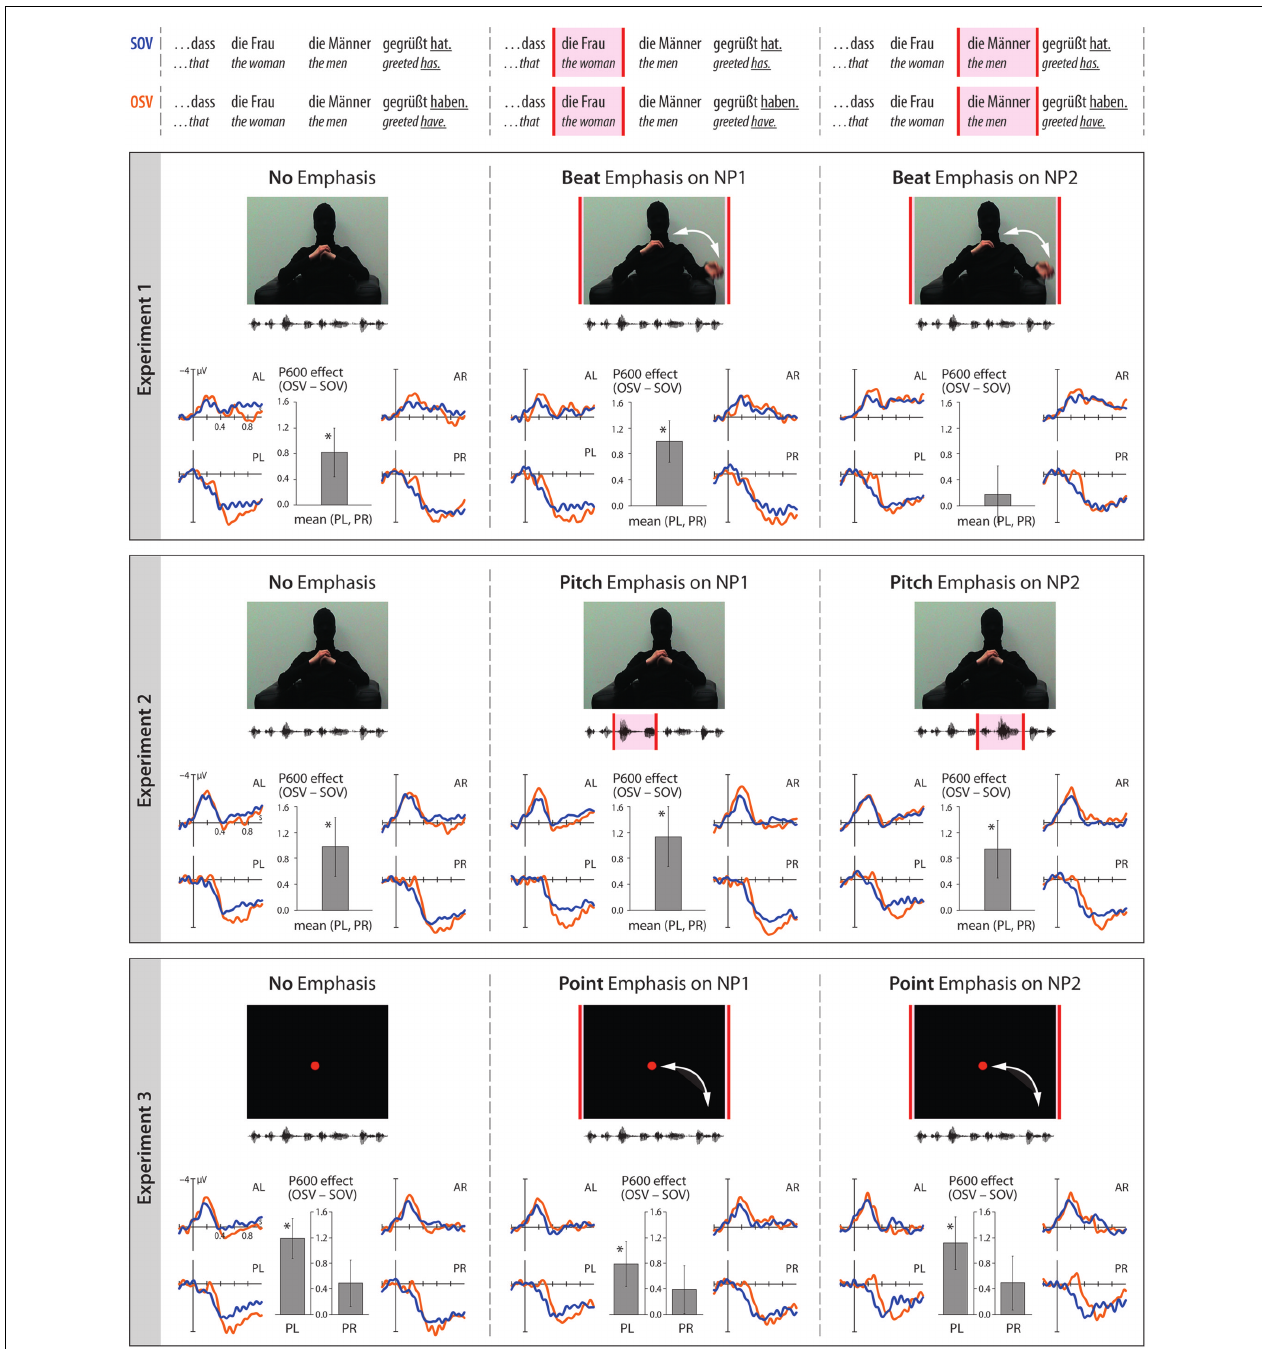
order (OSV) are shown in yellow. Grand-average ERPs (Experiment 1: n = 24; Experiment 2: n = 19; Experiment 3: n = 23) were averaged across four regions of interest: Anterior-Left (AL), Anterior-Right (AR), Posterior-Left (PL), and Posterior-Right (PR).Text highlighted by red bars indicates those portions of speech emphasized either by a visual beat gesture (Experiment 1), a beat-induced pitch accent (Experiment 2) or a moving point (Experiment 3). Bar graphs show the amplitude of the P600 effect ( ± SEM). ROIs in which the P600 effect is significant at p < 0.05 are marked by an asterisk